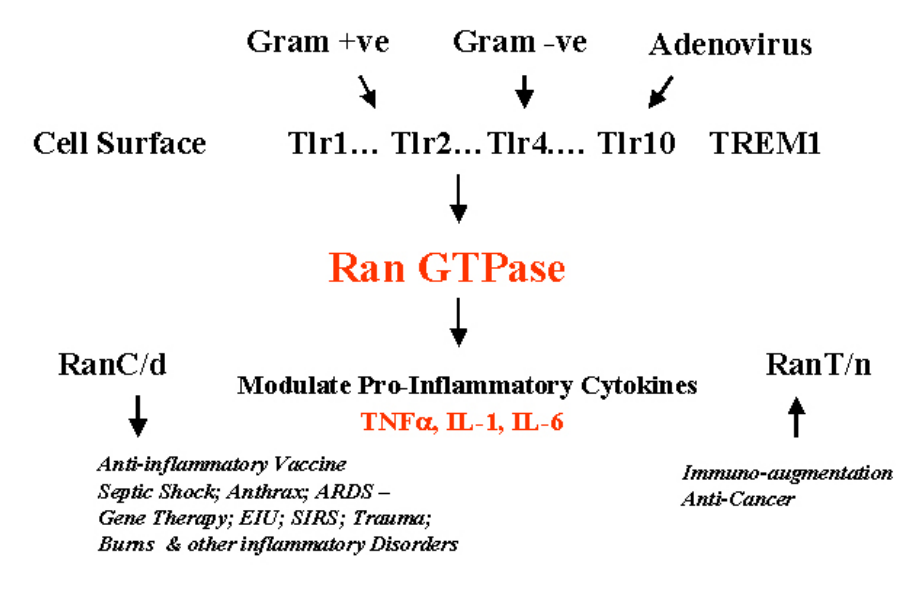
FIGURE 2. The role of Ran GTPase in host innate immune response and its potential clinical